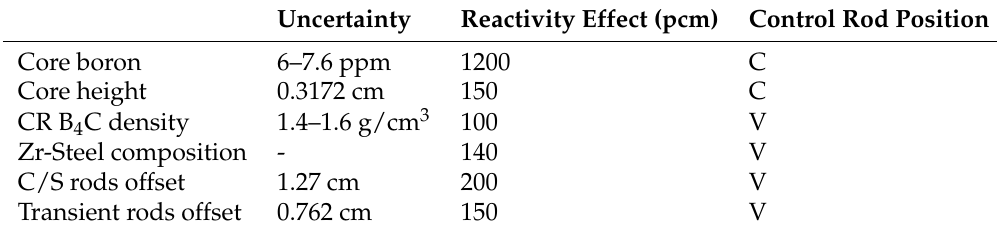
Table 4. Uncertain parameters of the TREAT neutronics